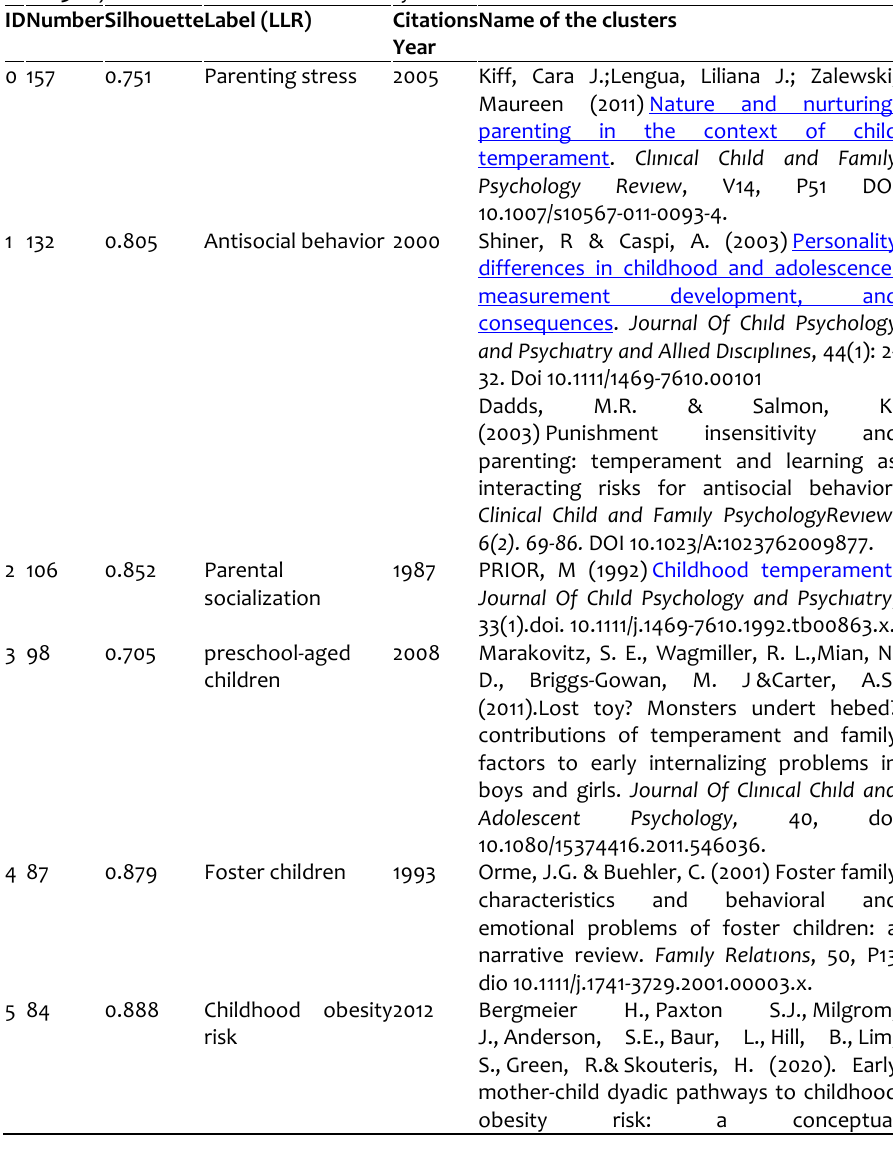
Table 3 . Information on clusters obtained by